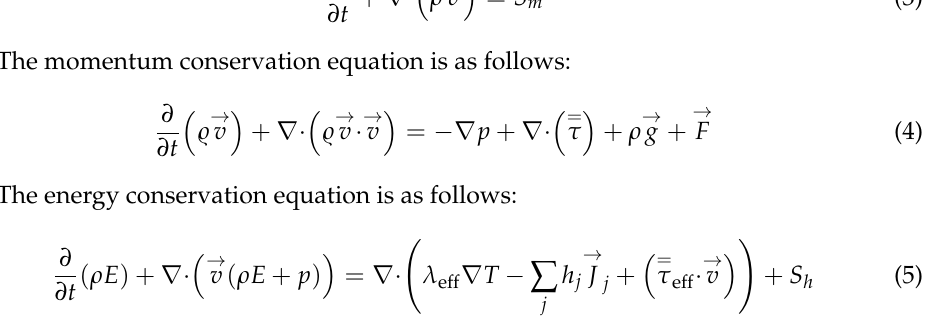
Figure 4. Cross-section of acomputational mesh of amodel with detailed geometry.